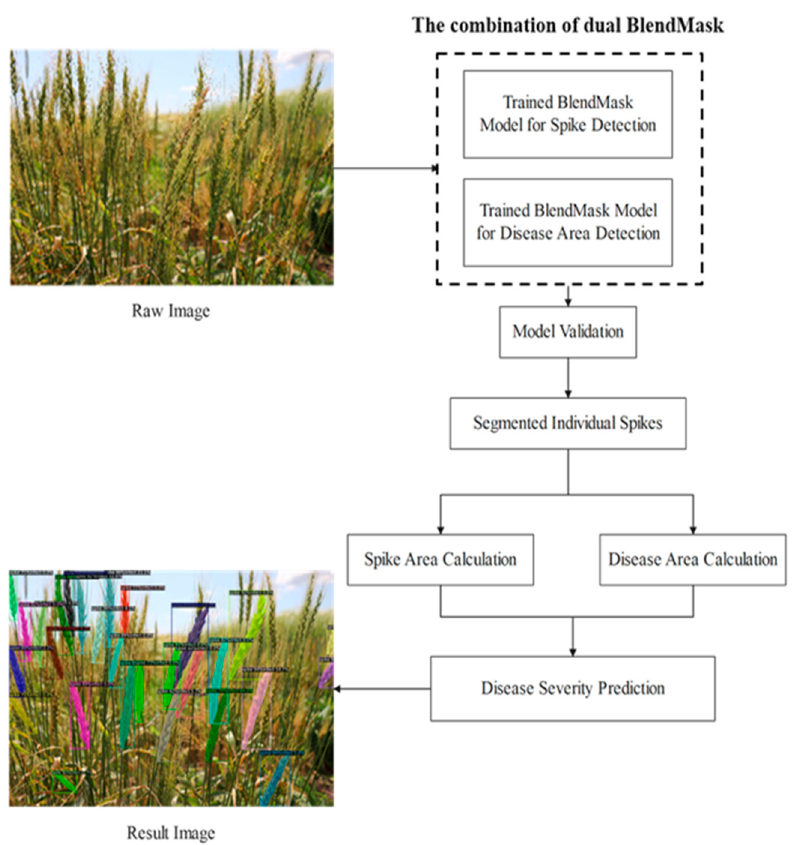
Figure 7. A flowchart of the combination of dual BlendMask models for evaluating FHB disease severity.